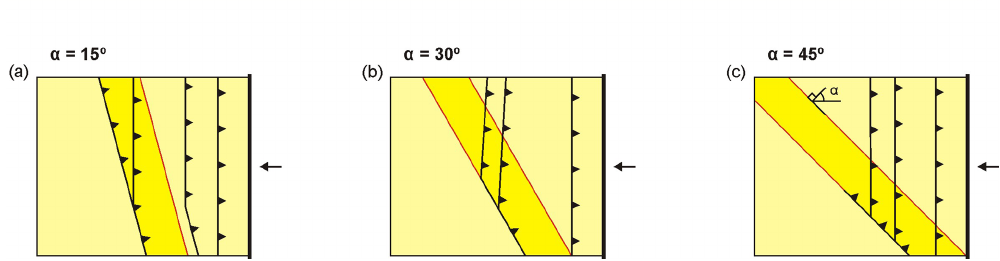
Figure 15. Effect of pre-existing graben orientation on fault reactivation during subsequent compression and inversion in brittle-only models, shown in map view. Grabens are indicated in yellow, and their orientation is defined as angle α , the angle between the normal to the graben strike and backstop motion direction. Image inspired by Yagupsky et al. (2008) and Deng et al.